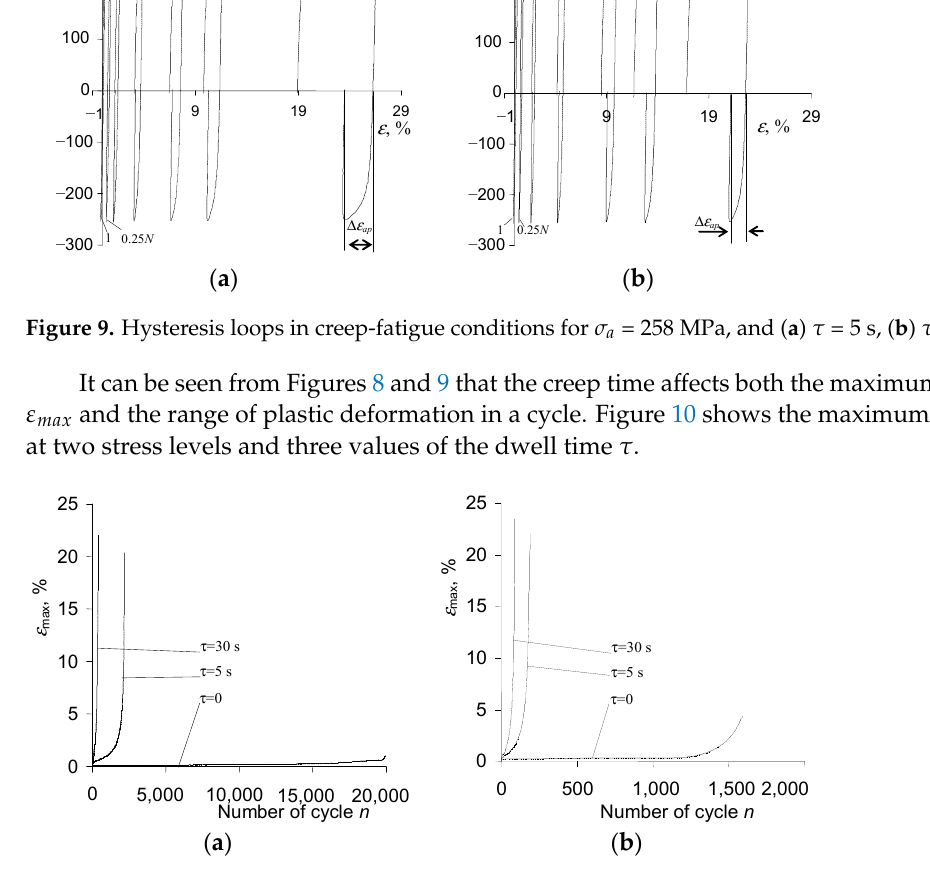
Figure 10. Maximum strain on cycle 𝜀 (cid:3040)(cid:3028)(cid:3051) versus number of cycles for different dwell times 𝜏 and different stress amplitudes: ( a ) 𝜎 (cid:3028) = 219 MPa, ( b ) 𝜎 (cid:3028) = 258 MPa.